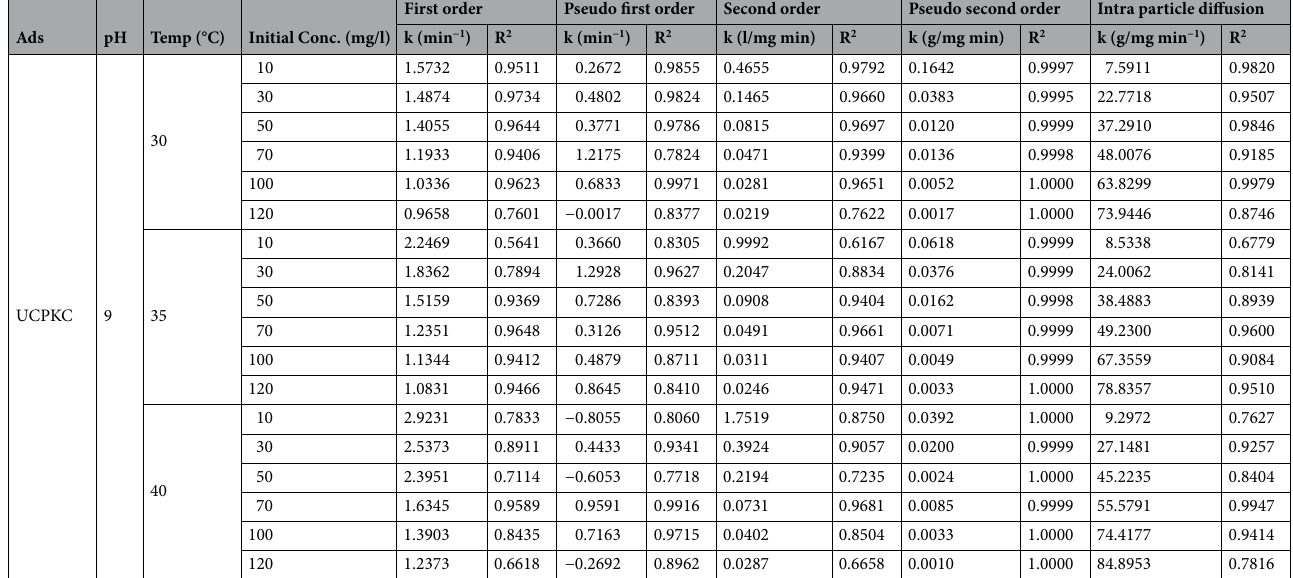
Table 5. R 2 and K values for various kinetic models for UPKC at pH 9 and Temperatures 30 °C, 35 °C and 40